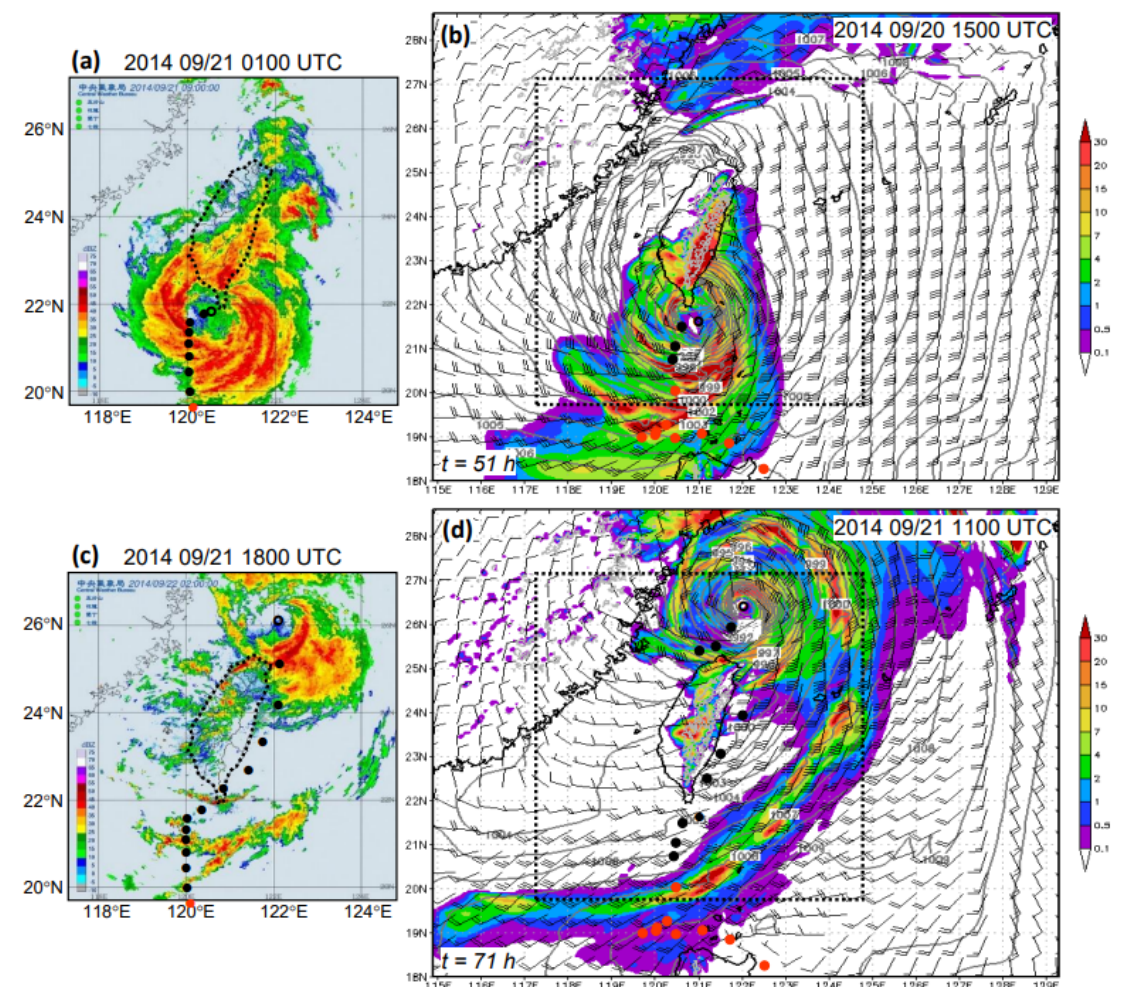
Figure 6. As in Figure 3, except for radar reflectivity (dBZ) at ( a ) 0100 and ( c ) 1800 UTC 21 September and CReSS model forecast ( t 0 at 1200 UTC 18 September) valid at ( b ) 1800 UTC 20 and ( d ) 1100 UTC 21 September 2014. The current typhoon center is marked by an open dot, and earlier positions (every 3 h) by solid dots (in red prior to 0600 UTC 20 September).